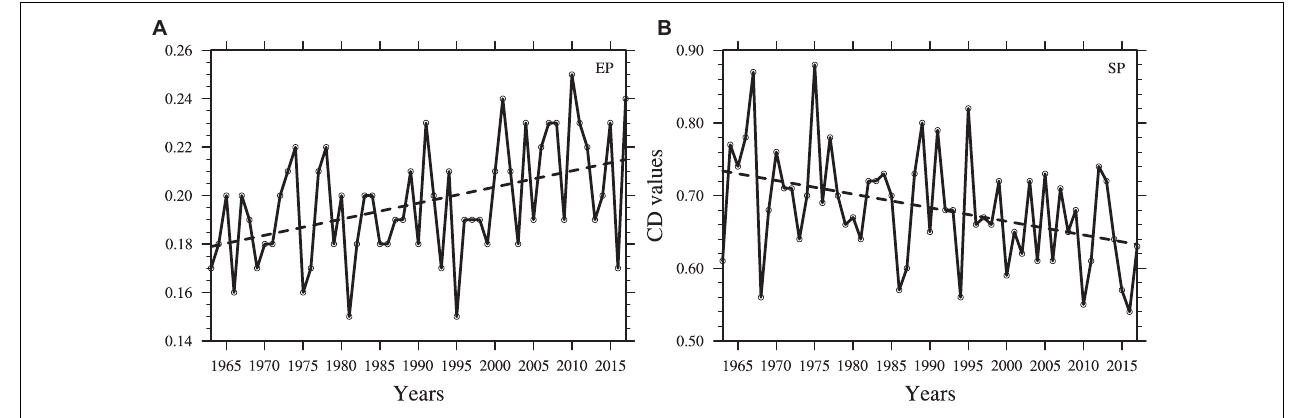
FIGURE 7 | Regionally averaged CD for: (A) SP, and (B) EP events over Northern Xinjiang from 1963 to